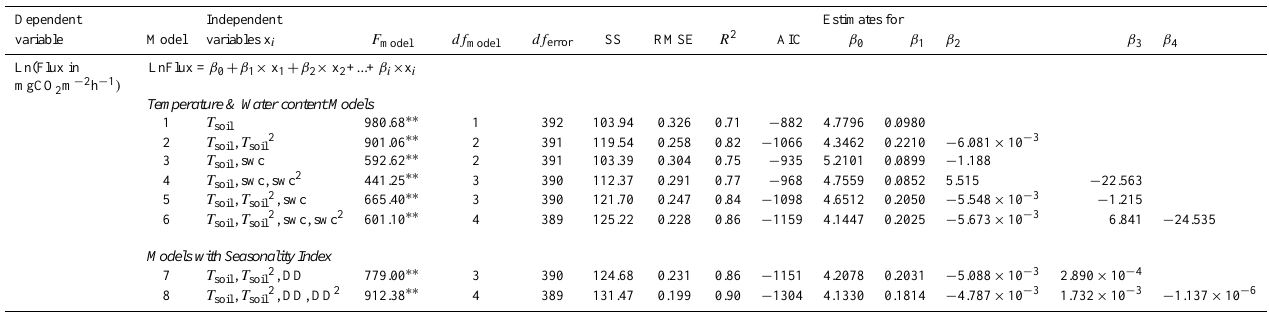
Dependent Independent Estimates for variable